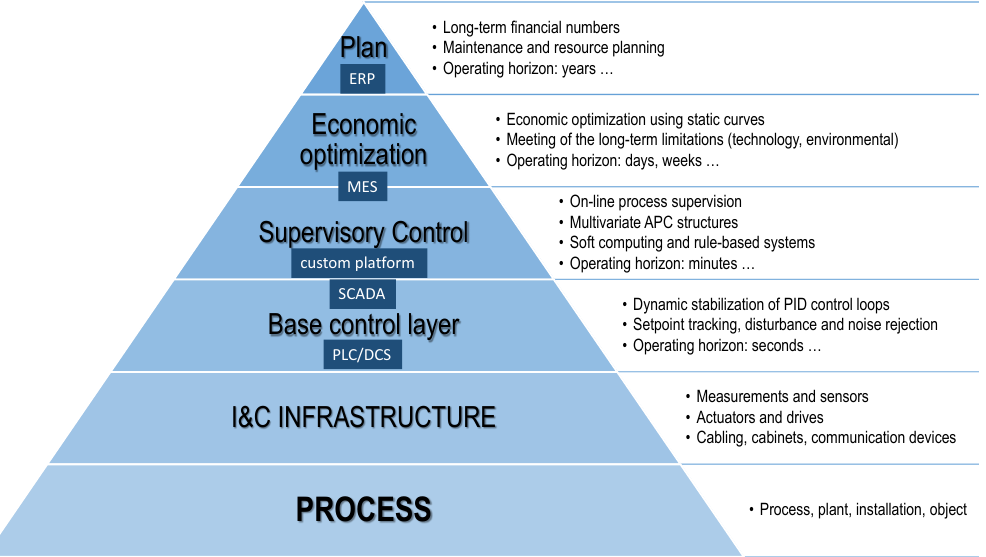
Figure 1. The hierarchical layout of a control system. APC, Advanced Process